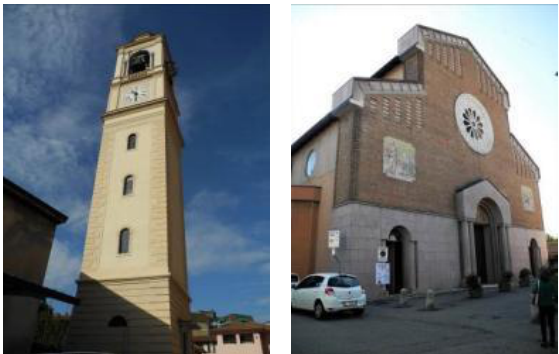
Figure 1. External views of the Church of St. Bernardino: a) The new bell tower and b) The added new façade The naves are defined by 12 twin monolithic columns in granite, three groups per side, which support four arches at the top. The walls that define the central nave are set above the four arches and are characterized by five single-lancet windows on each side. To cover the central nave, differently from the vaulted ceiling present in the original drawings, there is a wooden coffered ceiling that continues into the presbytery and the semicircular apsidal basin (Figure 2). This change of ceiling confirms the fair to add heavy structures on the load bearing walls of the central nave during the construction.